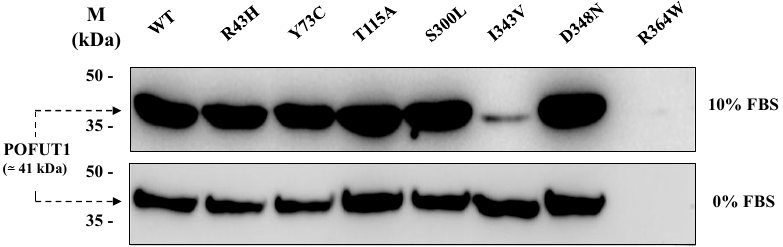
Figure 2. Western blot analysis, using anti-POFUT1 antibody, of recombinant POFUT1 variants secreted by stable CHO cell lines. Supernatants from each stable cell line were recovered by centrifugation from culture media after three days of protein production in F12 media with 10% (upper panel) or 0% (lower panel) fetal bovine serum (FBS). Same volumes of crude supernatants were loaded for WT and mutated POFUT1 proteins. Uncropped blots are shown in Figure S1.